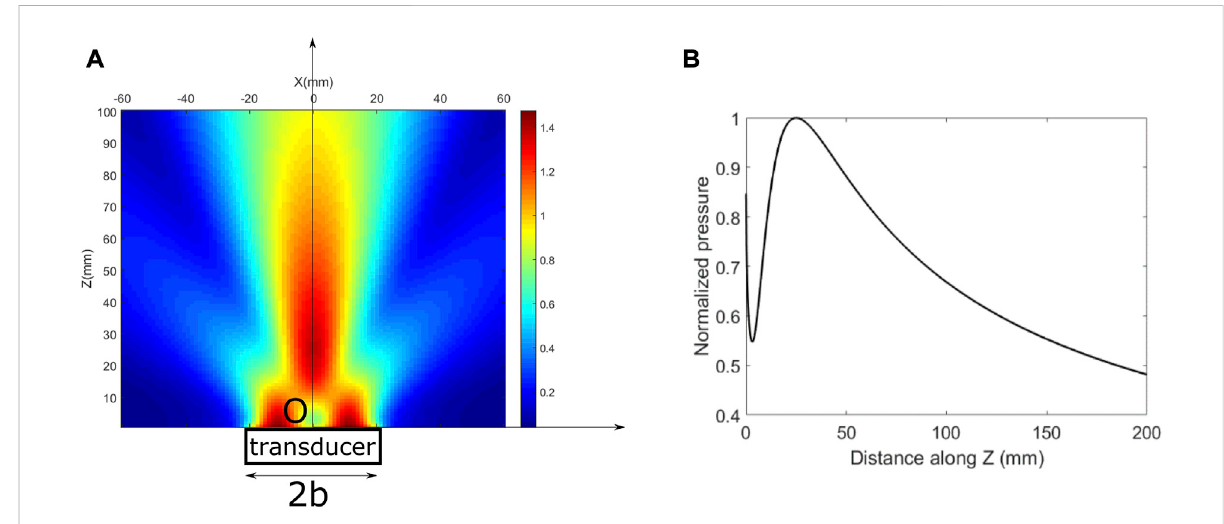
FIGURE 1 Normalized pressure distribution (A) full fi eld (B) along Z at x = 0. Calculations have been performed using Matlab